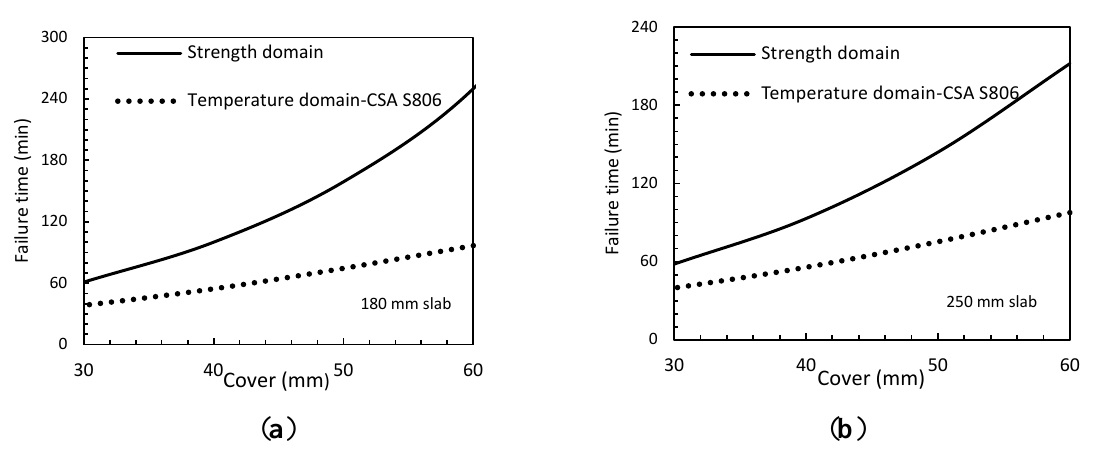
Figure 9. Strength-domain fire rate versus temperature-domain of CSA-S806 for ( a ) slab 180; and ( b ) 250